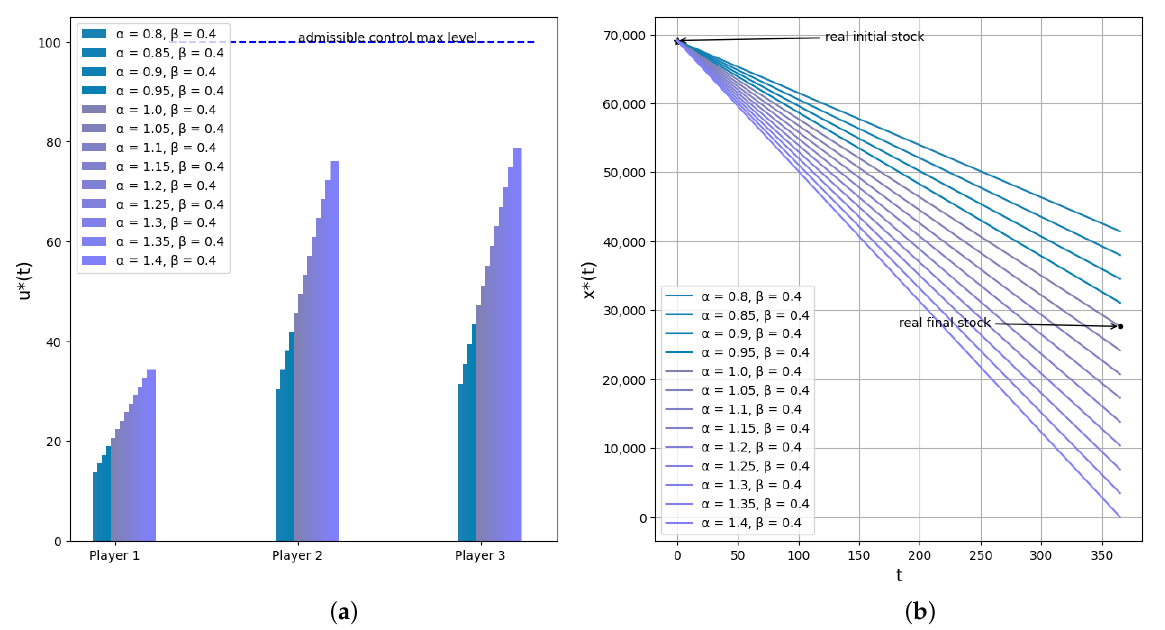
Figure 1. ( a ) The optimal controls of three players for the system with linear dynamics with case of uncertainty 1. ( b ) The optimal trajectories of three players for the system with linear dynamics with case of uncertainty